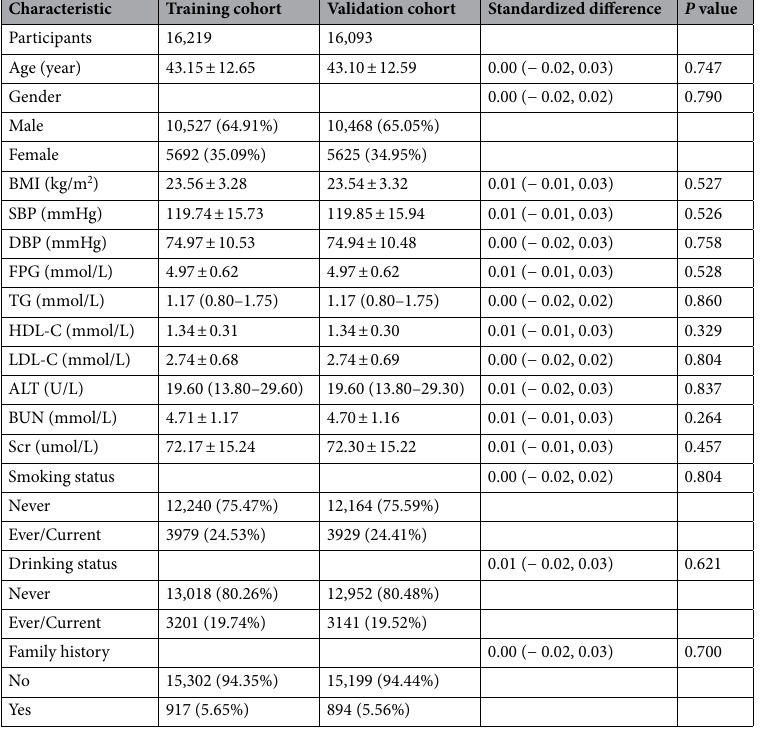
Table 1. Baseline characteristics of the training and validation cohorts. Values are n (%) or mean ± SD. BMI, Body mass index; SBP, Systolic blood pressure; DBP, Diastolic blood pressure; FPG; Fasting plasma glucose; TG, Triglyceride; HDL-C, High density lipoprotein cholesterol; LDL-C, Low density lipid cholesterol; ALT, Alanine aminotransferase; BUN, Blood urea nitrogen; Scr, Serum creatinine; Family history, Family history of